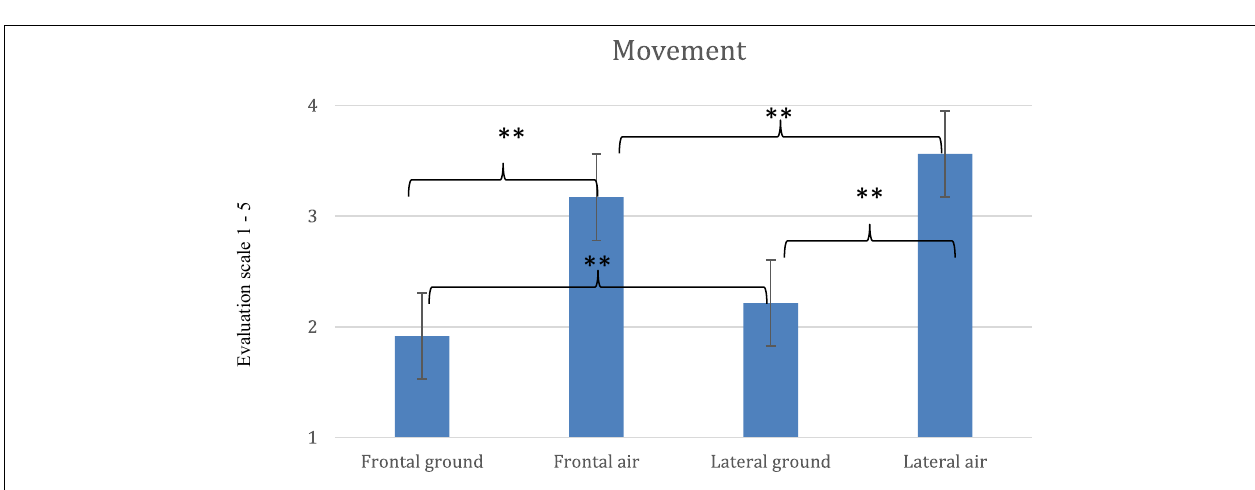
p < 0.05), indicating Difficulty has an extra effect over and